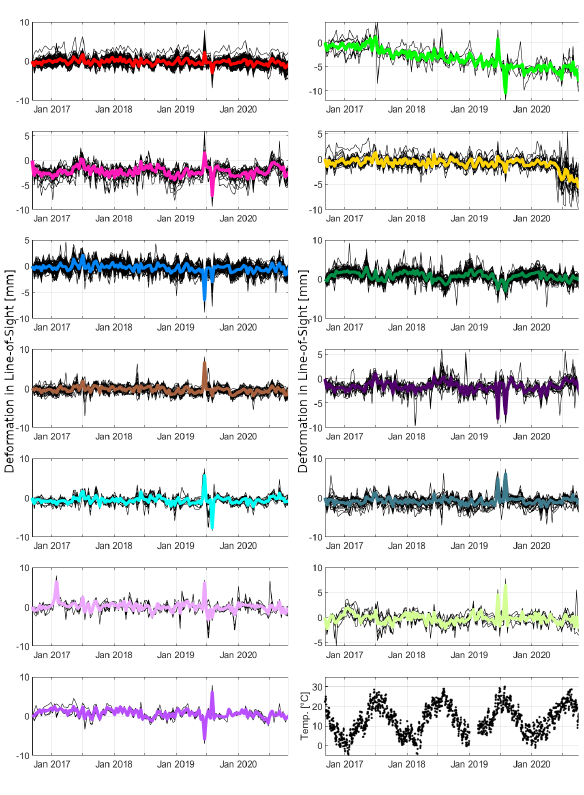
Figure 11. Time series of clusters on building B. The center point of each cluster is plotted in color. The colors correspond to the clusters in Figure 10. The bottom plot shows the mean daily temperature. We are not sure about the origin of the ”spikes” around June 2019. They could be processing artifacts due to atmospheric